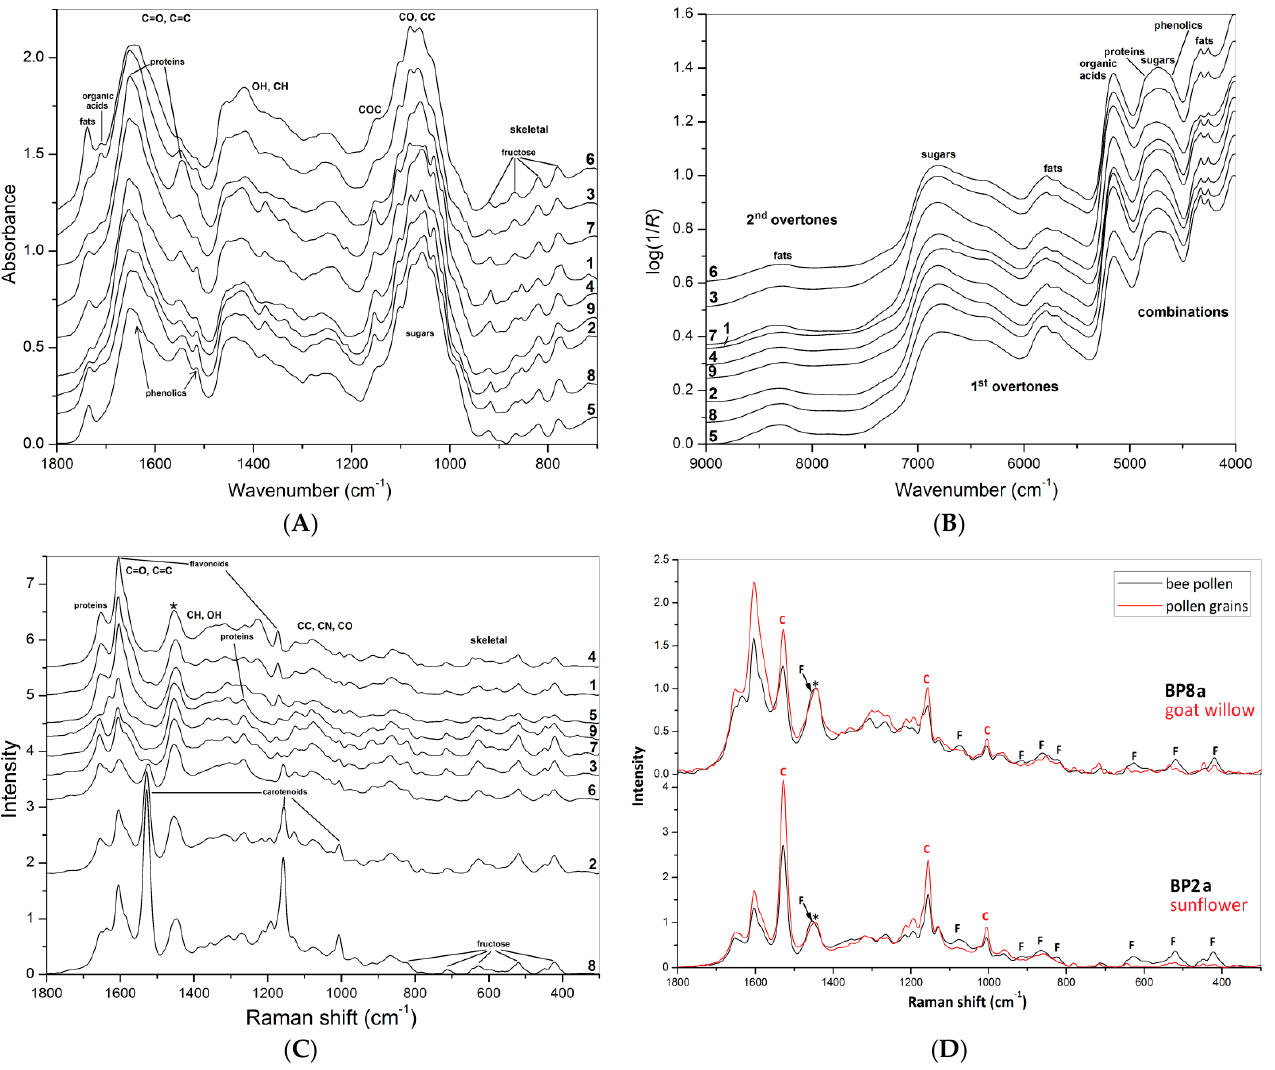
Figure 2. Average FT-MIR ( A ), FT-NIR ( B ), and FT-Raman ( C ) spectra of BP1 – 8 and 9 _1; comparing FT-Raman spectra ( D ) of bee pollen loads BP2a , BP8a (black) and corresponding plant pollen grains (red), i.e., sunflower and goat willow, respectively (c—carotenoids, f—fructose), asterisk indicates position of normalized band.